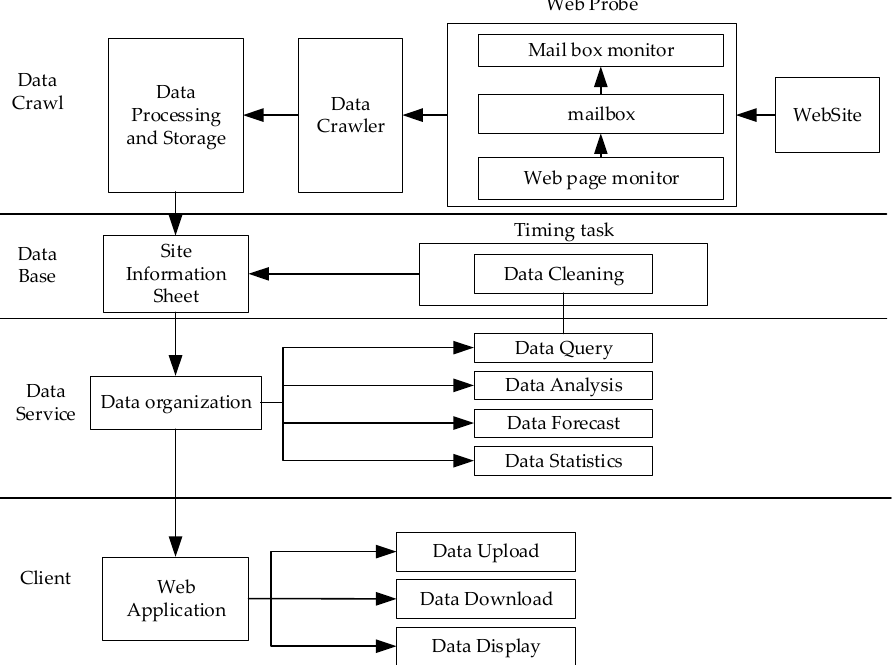
Figure 1. The philosophy of water-quality-prediction and early-warning system.